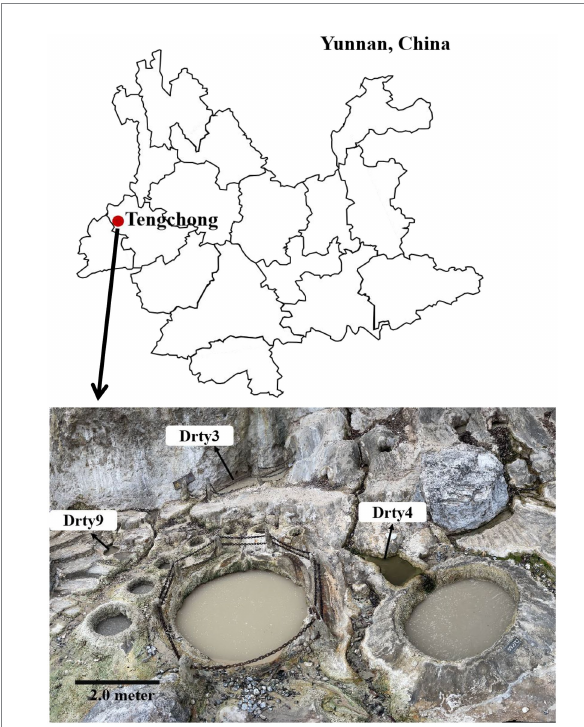
FIGURE 1 Location of Tengchong (red solid circle) in Yunnan Province, southwestern China, and the distribution of hot springs. Scale bar, 2 m. (Figure 2). Based on virion morphologies, the VLPs could be assigned to four types: filamentous virions, rod-shaped virions, spherical virions, and spindle-shaped virions. Although these nine hot spring samples are located close and share many common characteristics, we found that the morphologies and number of VLPs observed were significantly different even after cultivation with the same growth medium and conditions (Supplementary Table S2). Among them, three major types of virions, i.e., the filamentous (Figure 2A), polyhedral (Figure 2E), and tailed spindle-shaped (Figure 2H) virion were observed in the enrichment cultures of three samples Drty3, Drty4, and Drty9, which were further used to isolate VLP-propagating strains.